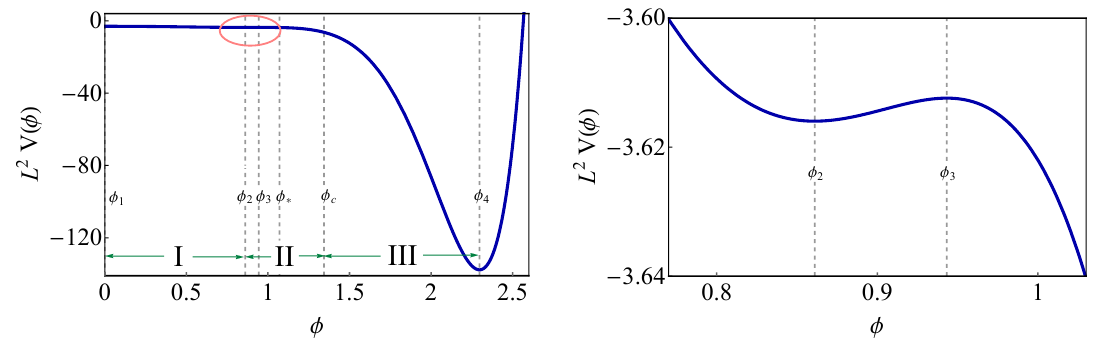
Figure 3 . Potential of our model. The de(cid:12)nition of the points (cid:30) (cid:3) , (cid:30) c and the di(cid:11)erent regions labelled I, II and III will be explained around eqs. (3.2) and (3.5). On the right we zoom into the region marked with a red circle on the